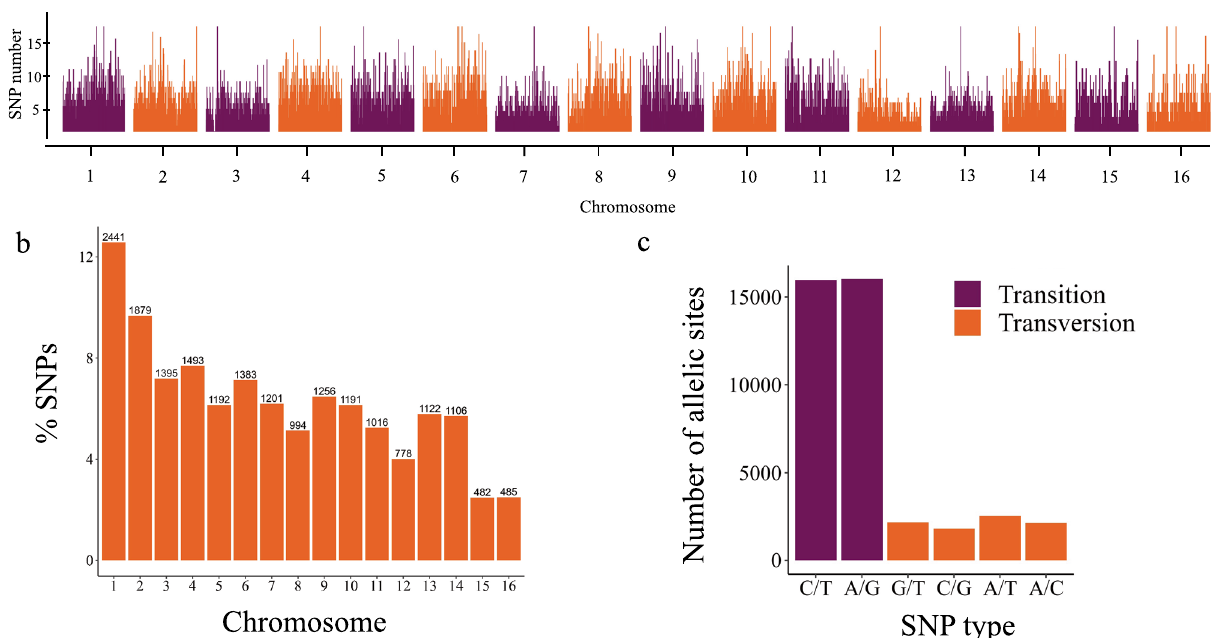
Figure 1. Identification of 19,414 single nucleotide polymorphisms (SNPs) obtained from the genotyping of 112 coconut accessions. ( a ) Distribution of SNP density along Hainan Tall coconut genome. ( b ) Proportion of SNPs in each chromosome. ( c ) Transversion/transition ratio. Figure produced in R v.4.0 (2020) 56